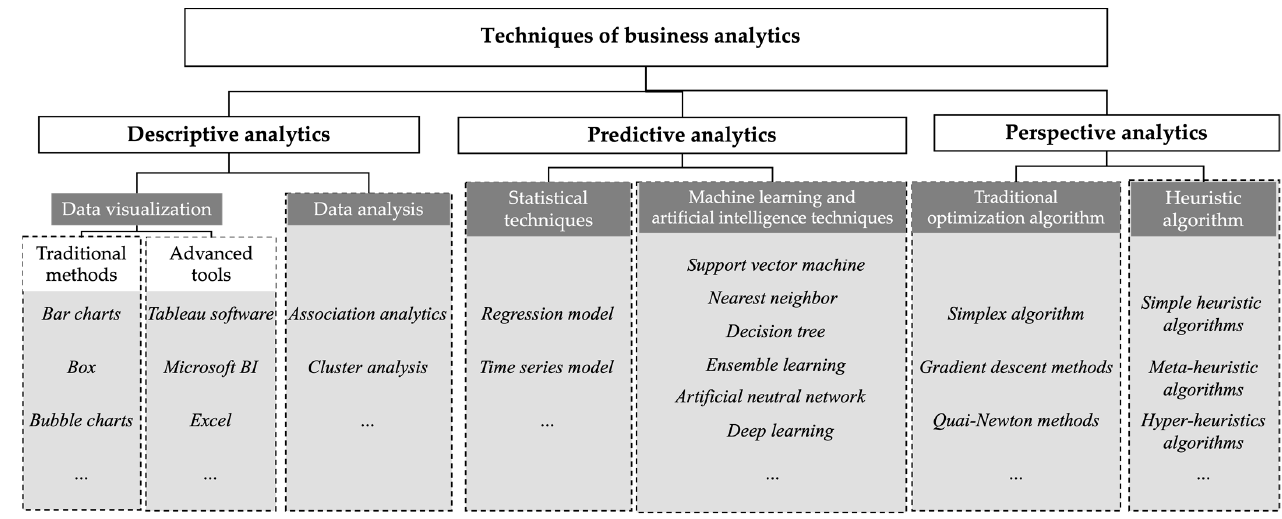
Figure 4. Summary of techniques mentioned in Section 4.